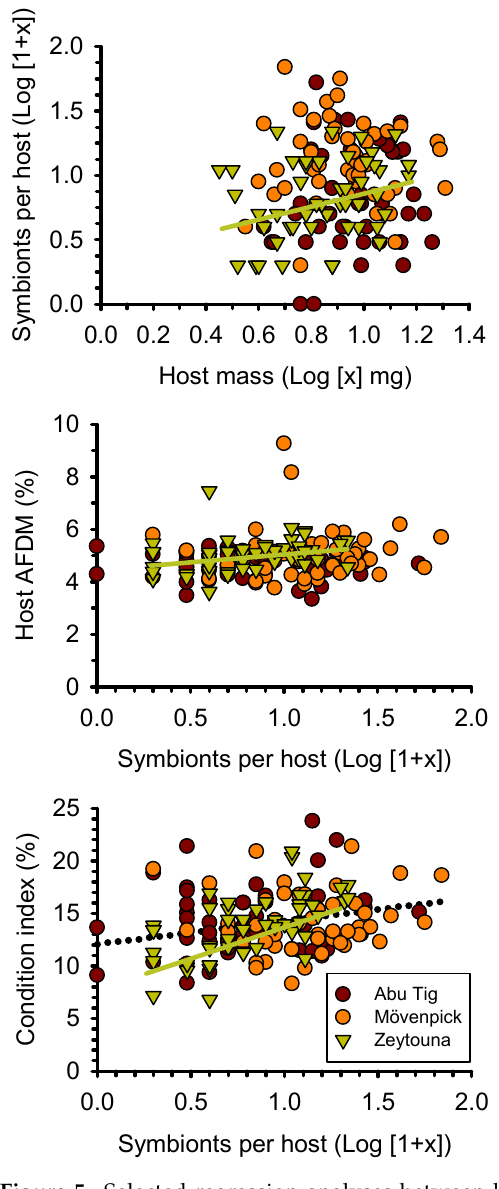
Figure 5. Selected regression analyses between host and total symbionts showing the variation of these patterns among reefs. Colored regression lines indicate the reef for which a significant relationship was found. The dotted line on the bottom graph shows the only case in which a general relationship between the two variables considered was found when all data for the three reefs were pooled. See Table A1 for results of all other comparisons performed.